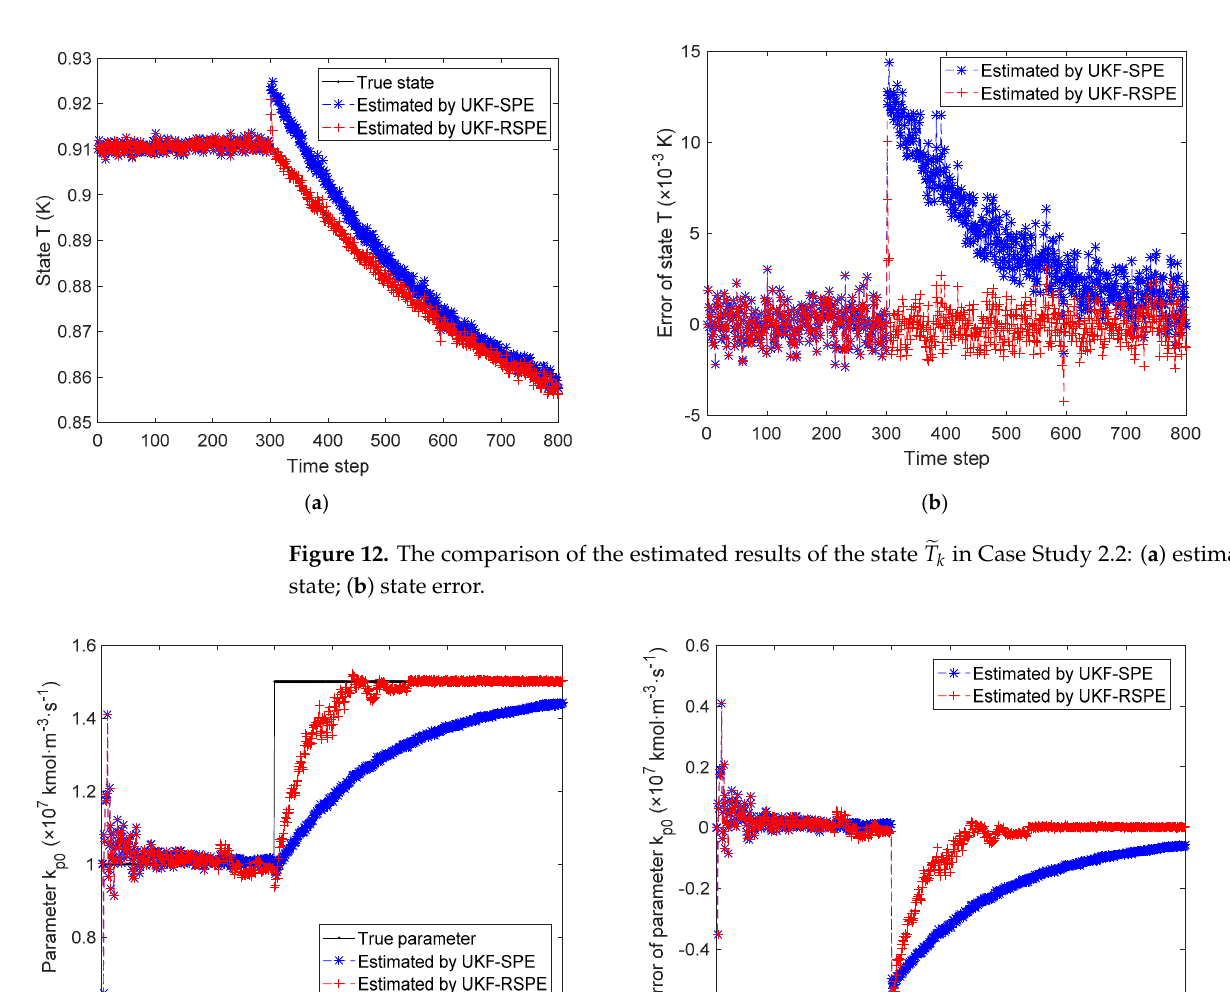
k in Case Study 2.2: ( a ) esti- ,0 p